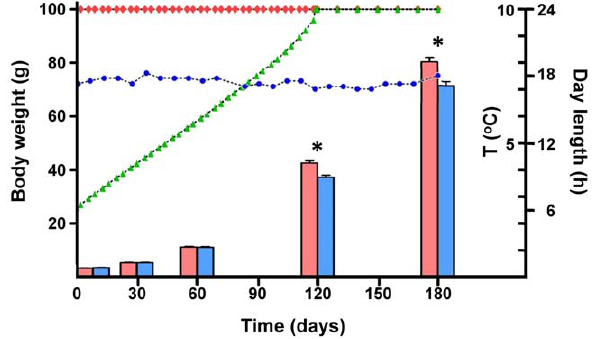
Figure 1. Growth history of Atlantic cod juveniles reared under continuous light (LD 24:0, red bars) or natural photoperiod conditions (LDN, blue bars) for six months. Details of the light regimes are shown by red diamonds or green triangles for LD 24:0 and LDN groups, respectively. Sea water temperature is also indicated by blue circles. Significant differences in mean weight between the two light groups at a particular time point (two-tailed t-test, n=123) are highlighted by an